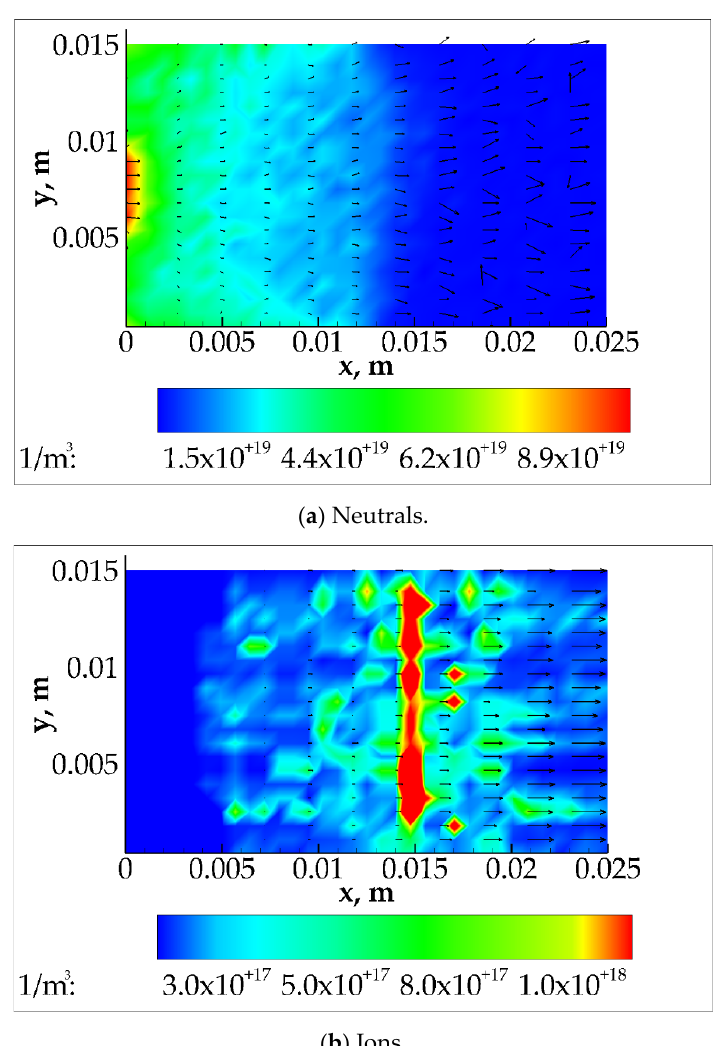
Figure 6. Contours of the neutral and ion densities with the average cell’s velocity vectors.